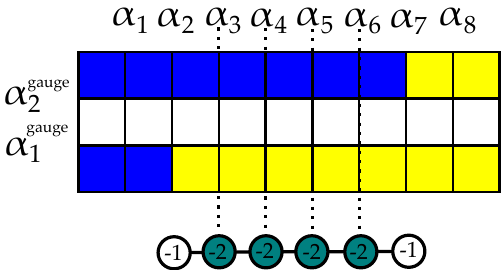
Figure 5. Flavor-equivalence class and BG-CFD: in this (cid:12)gure we show an example for a (cid:13)avor- equivalence class of Coulomb branch phases for SU(3) with 9 F . The top graph is the box graph reduced to its (cid:13)avor-equivalence class by omitting the sign assignments in the middle row: all sign assignments consistent with the standard box graph rules would correspond to the same combined gauge root splitting. This is encoded in the CFD-subgraph that we refer to as BG-CFD: the roots (cid:11) i , i = 3 ; 4 ; 5 ; 6 of G BG = U(9) that participate in the splitting of the roots (cid:11) gauge are ( (cid:0) 2)-vertices in the CFD | shown at the bottom. The ( (cid:0) 1)-vertices of the CFD correspond to the F-extremal weights ( (cid:0) L 3 ; 3 ) and L 1 ; 7